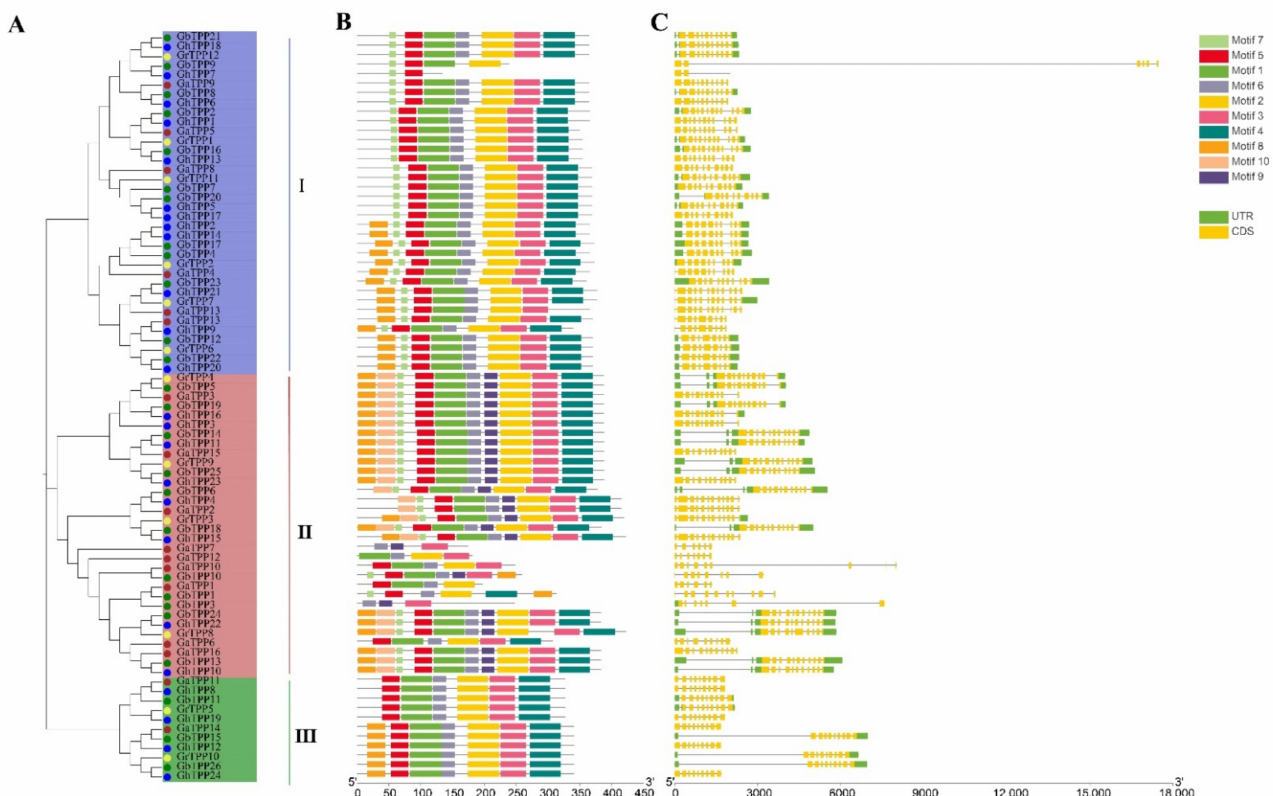
Figure 2. Conserved motifs and structure of TPP genes in cotton. ( A ) The phylogenetic tree was constructed using the protein sequences encoded by 79 TPP genes in cotton. The TPP genes were divided into three groups based on the evolutionary tree. ( B ) The conserved motifs in TPP genes were predicted, and the different colours represent different motifs. ( C ) The intron/exon structures of the TPP genes were analysed. The yellow boxes represent exons, the grey lines represent introns, and the green boxes represent untranslated regions